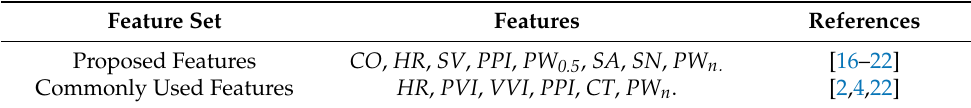
Table 1. The Two Sets of Features